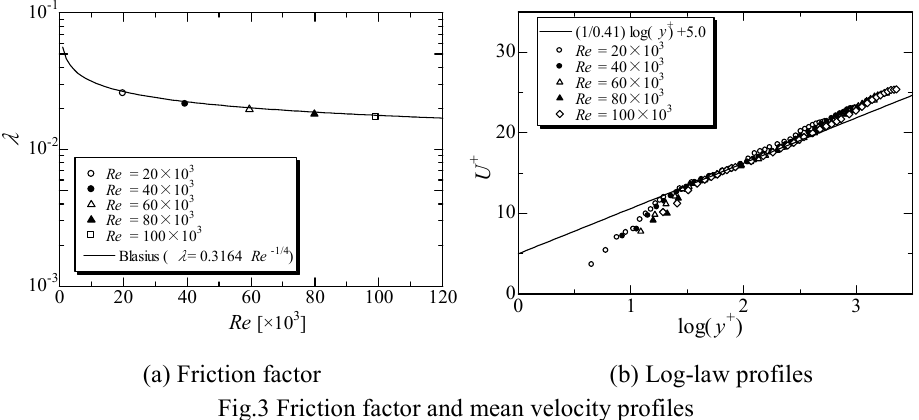
Fig.3 Friction factor and mean velocity